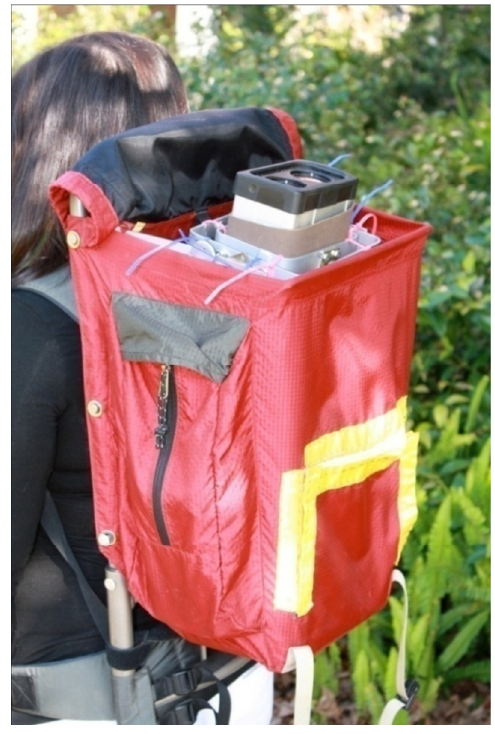
Figure 2 . Portable light detection and ranging (LiDAR) unit in the backpack